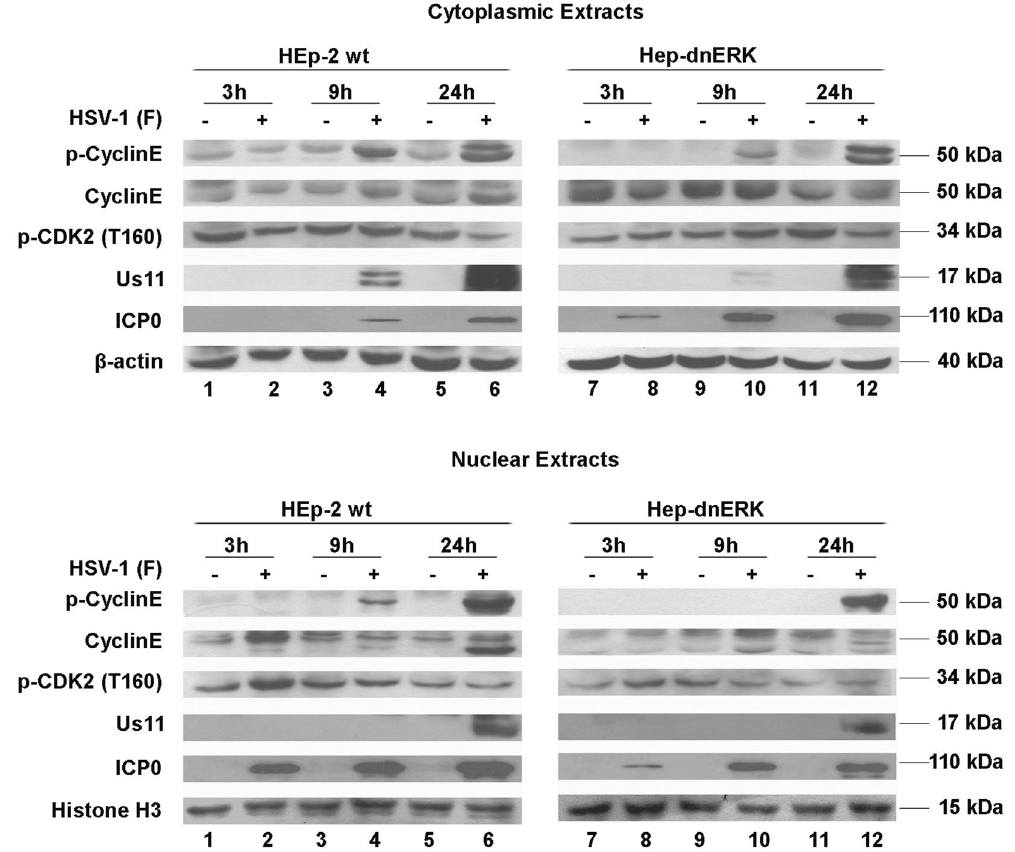
Figure 4. Cyclin E and CDK2 expression in dominant negative-ERK cells during HSV-1 replication. HEp- dnERK and HEp-2 cells were exposed to HSV-1 at MOI 10 and collected at 3, 9 and 24 h p.i. Cells were processed for cytoplasmic and nuclear proteins extraction as described in Methods and were analyzed by immuno-blot for the expression of total protein cyclin E, phospho-cyclin E, phospho-CDK2 (T160), Us11 and ICP0 proteins. β -actin and Histone H3 were used as cytoplasmic and nuclear loading controls, respectively. The filters derived from extracts obtained from both HEp-dnERK and HEp-2 cell lines were exposed